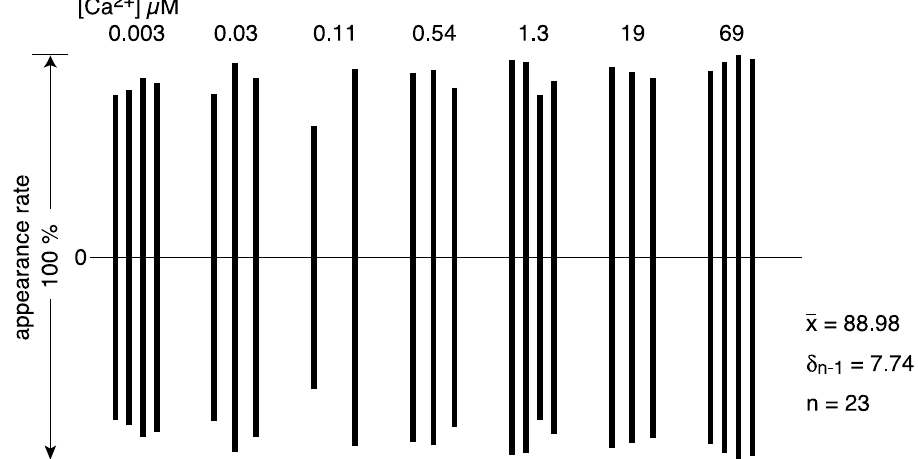
Figure 7. Percentages (%) of the number of round vesicles with a crystal patch assembly of ATPase relative to the total number of vesicles present in each of the four views recorded at the respective calcium concentration in the absence of ATP (see text for details).